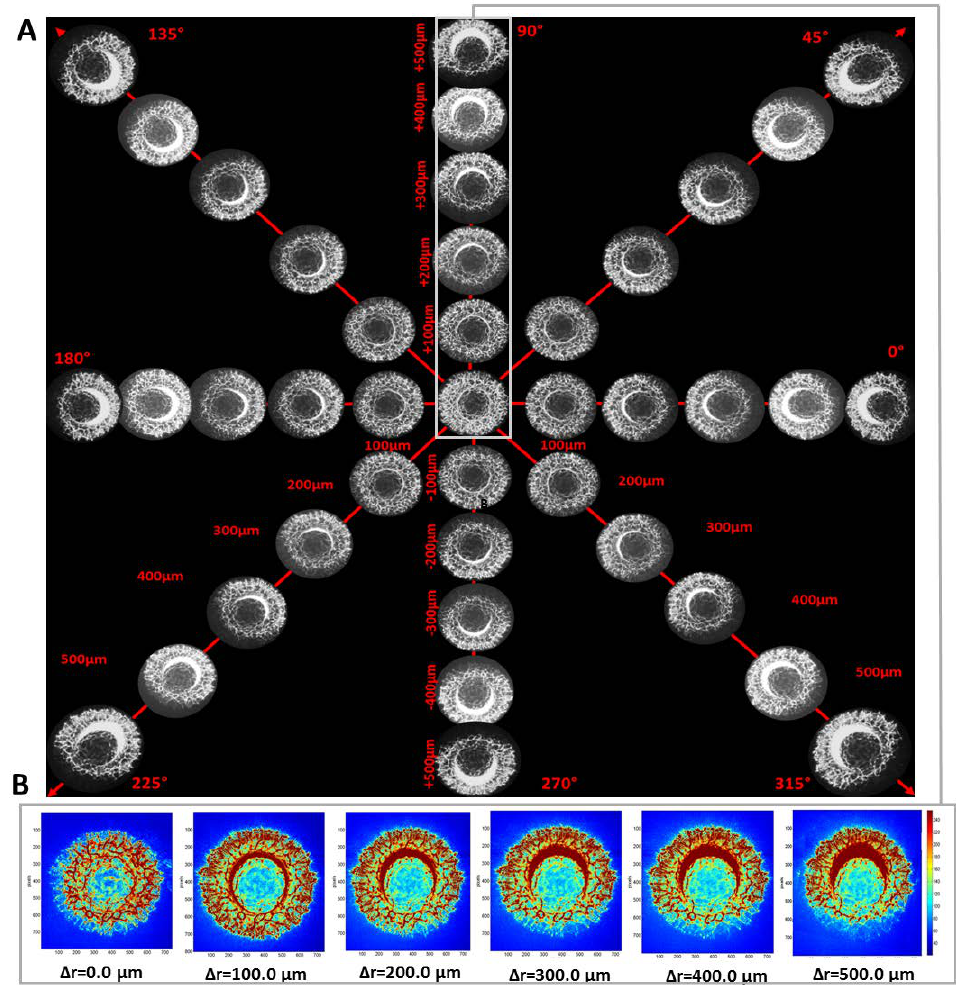
Figure 4. ( A ) The representative deformation of the di ff raction patterns for various ∆ r-parameter values (100–500 µ m) along four di ff erent misalignment directions Θ = 0 ◦ ;180 ◦ , 90 ◦ ;270 ◦ , 135 ◦ ;315 ◦ , 45 ◦ ;225 ◦ . ( B ) The exemplary images of the bacterial colony di ff raction patterns for di ff erent values of the ∆ r-parameter in the vertical direction ( Θ = 90 ◦